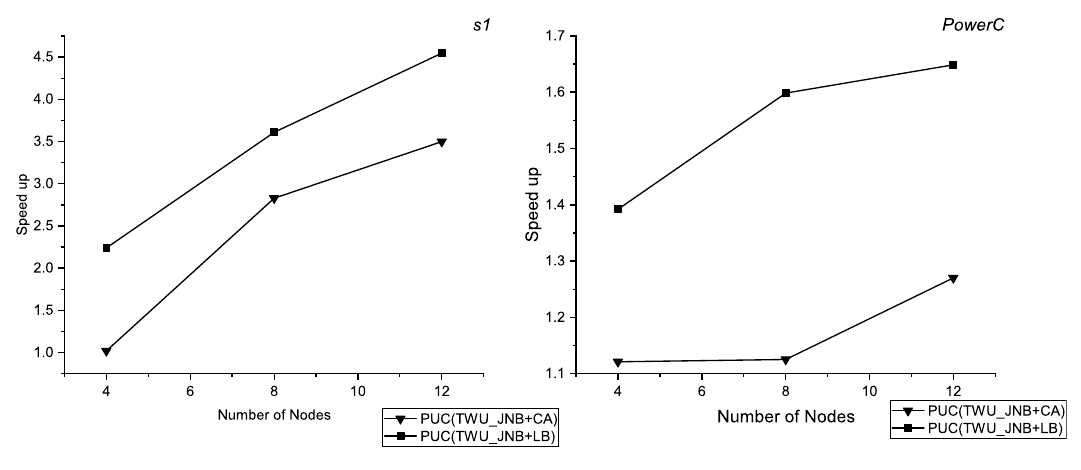
Figure 10: Comparison of speedup of